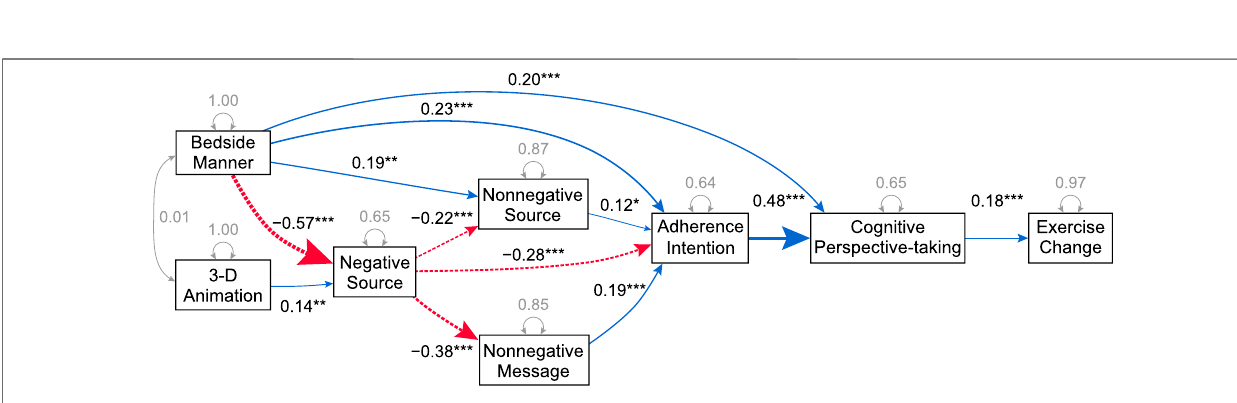
Frontiers in Virtual Reality |